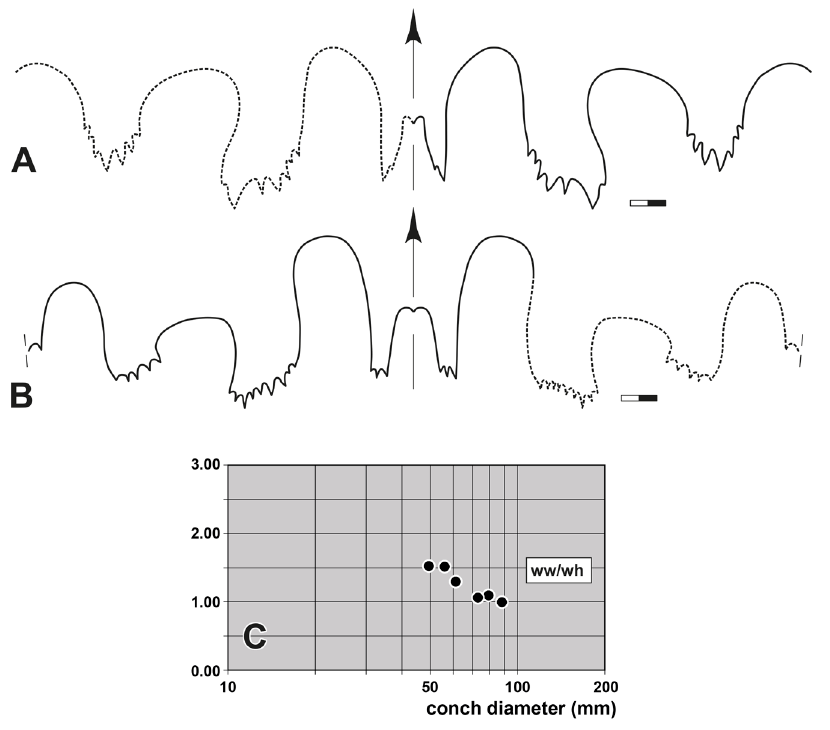
Fig. 27. Paratirolites robustus Korn & Hairapetian sp. nov. A . Suture line, holotype MB.C.29778, at 14.2 mm wh. B . Suture line, paratype MB.C.29782, at 13.2 mm wh. C . Whorl profile proportions. Abbreviations: see Material and methods. Scale bar units =